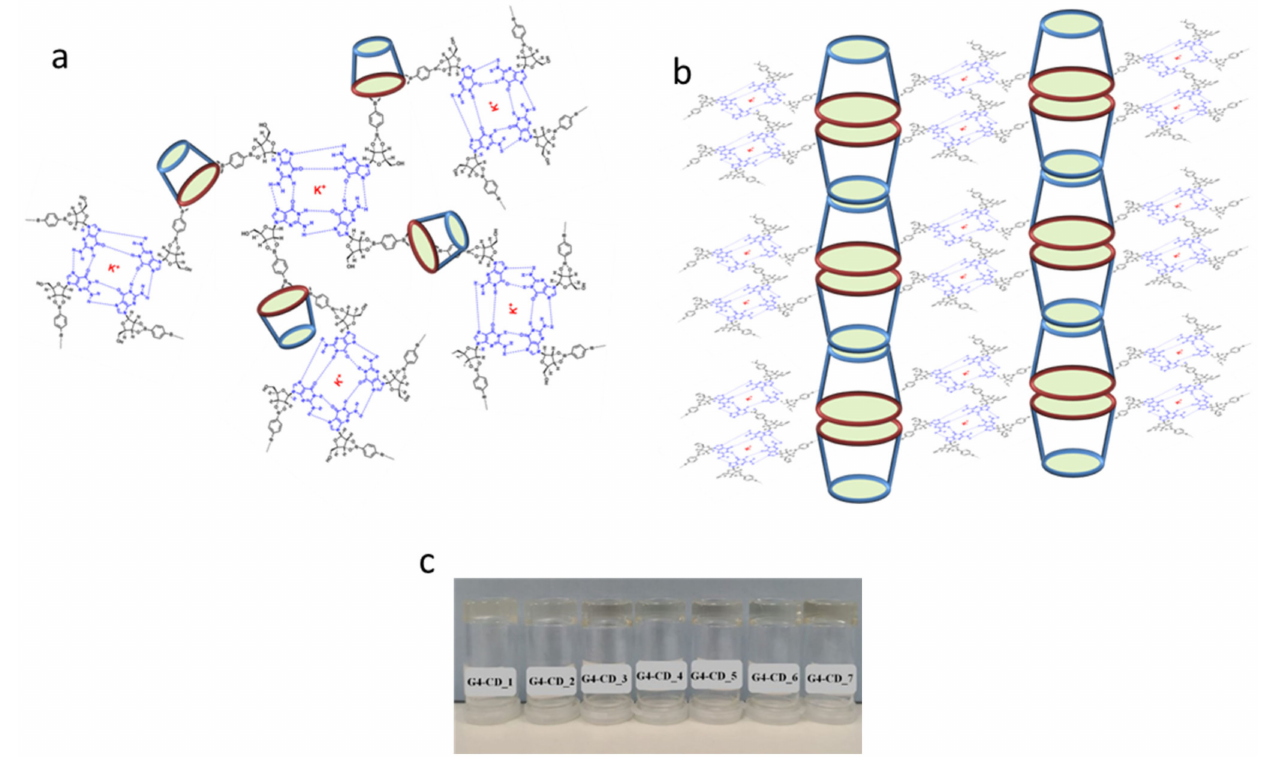
Figure 1. Example of the G4–CD hydrogels network formation ( a ), each guanosine moiety linked to the β –CD molecule through the benzene–1,4–diboronic acid linker participate in the formation of G4 in the presence of potassium ion; possible stacking of β –CD molecules ( b ), driven by the multiple G4 formations; ( c ) picture of self–standing G4–CD_1–7 hydrogels with varied concentration of β